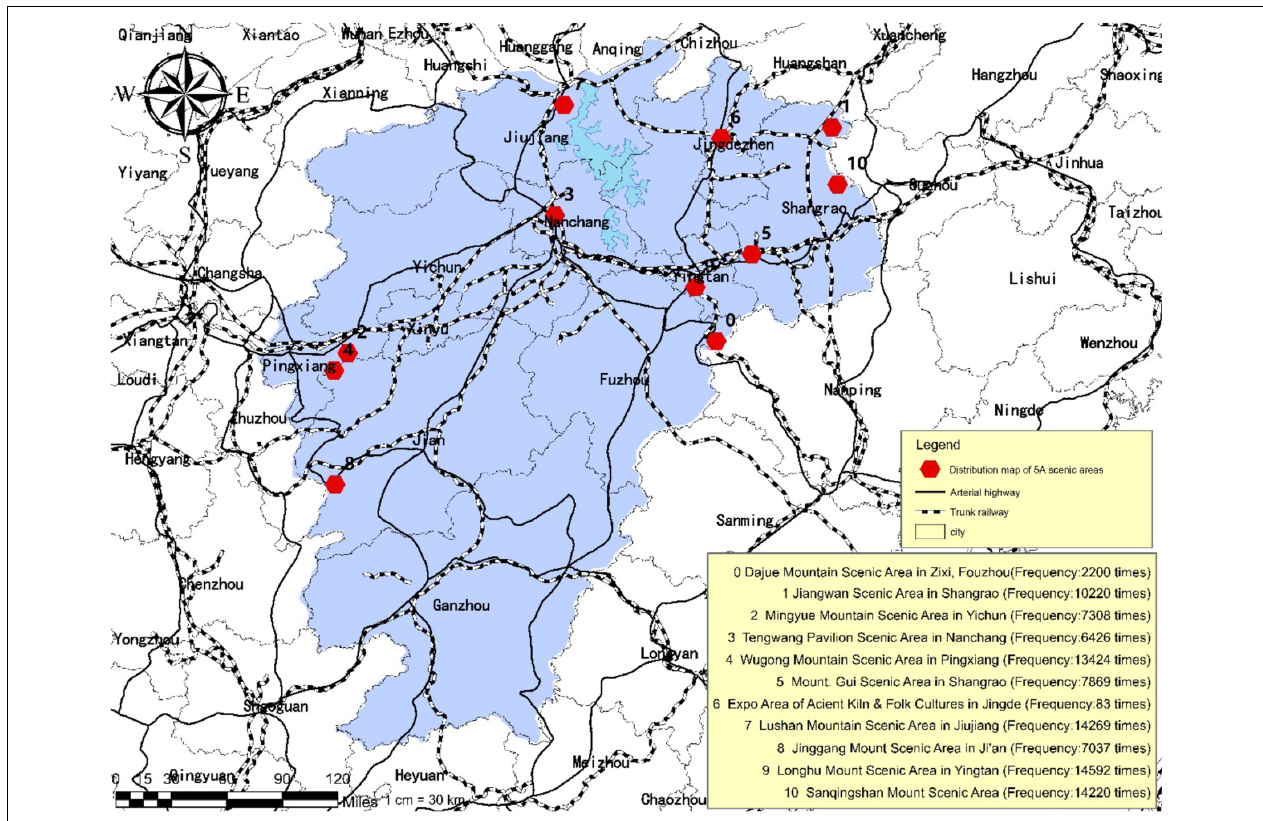
FIGURE 5 | The tourism routes distribution of tourism destinations in Jiangxi